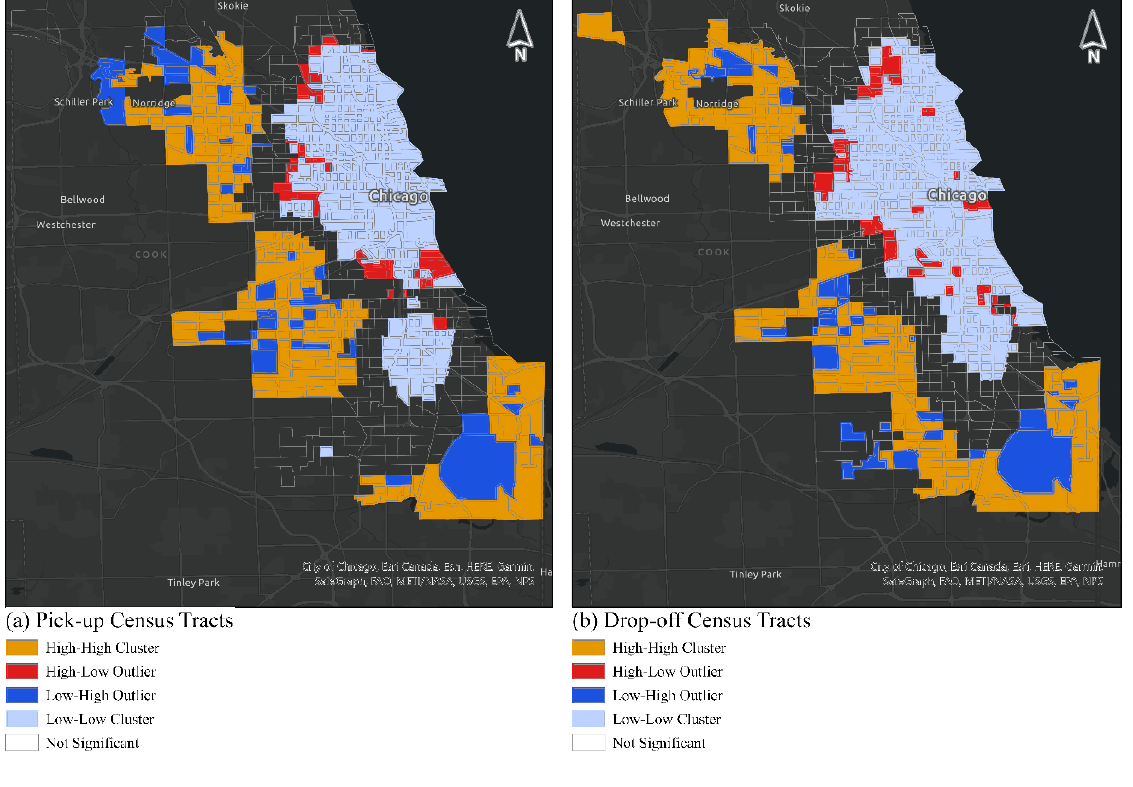
Figure 10: Cluster and Outlier Analysis of TNC Trips' Length-Duration Principal